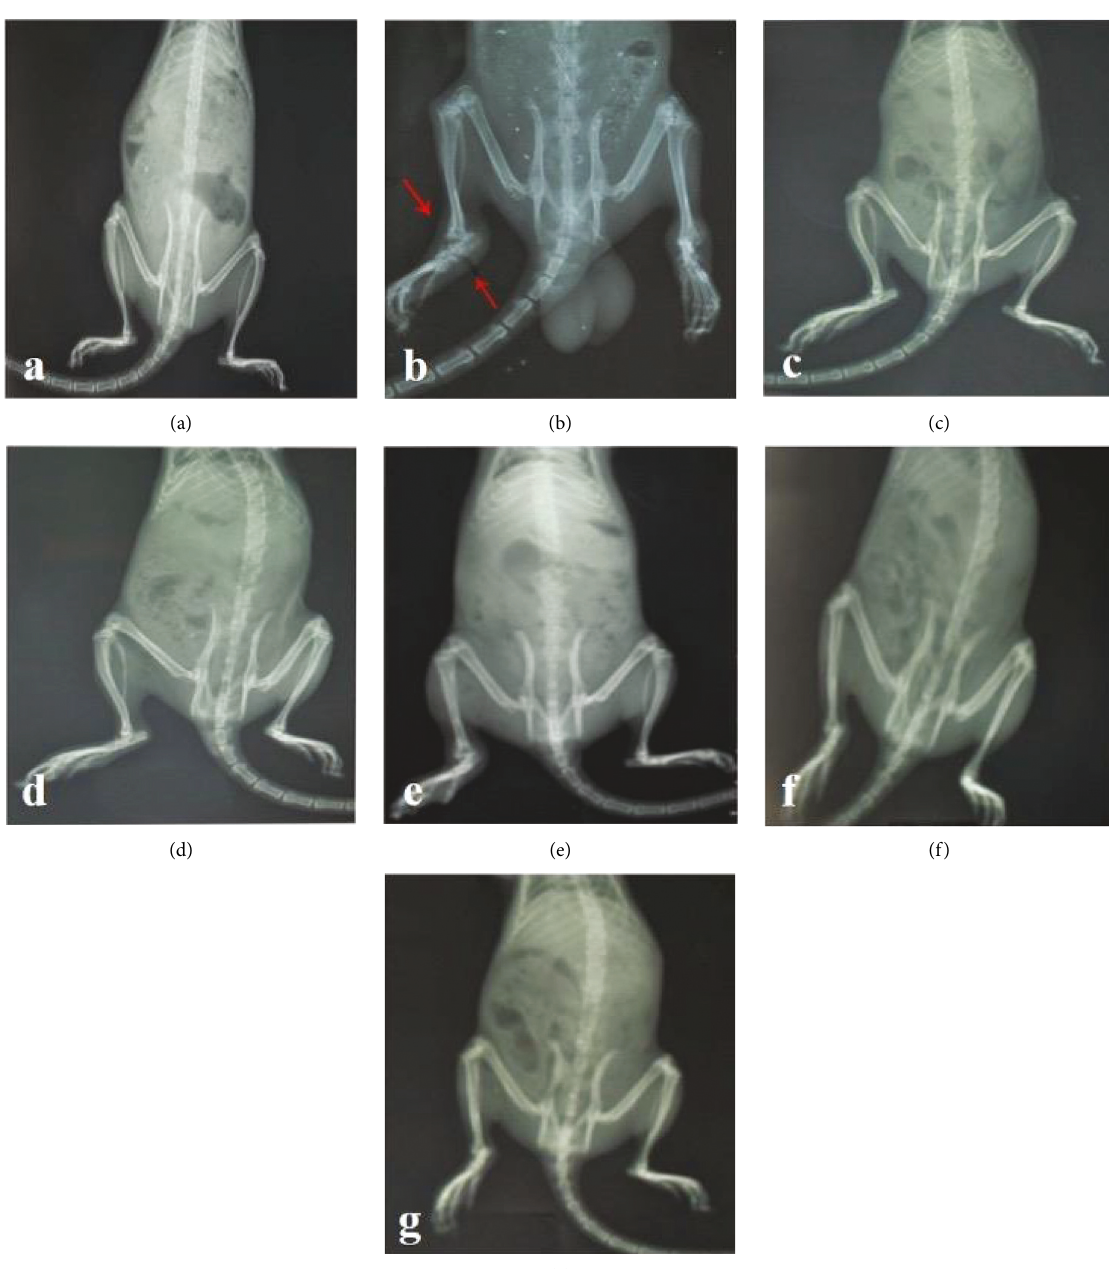
Figure 5: Effect of Bombax costatum extract on adjuvant-induced arthritis in rats. (a) Incomplete Freund’s adjuvant (nonarthritic) group, (b) complete Freund’s adjuvant (arthritic control) group,(c) methotrexate (1.0 mg/kg, ip), (d) dexamethasone (3.0 mg/kg, ip), and (e)–(g) extract (10–100 mg/kg, p.o.),